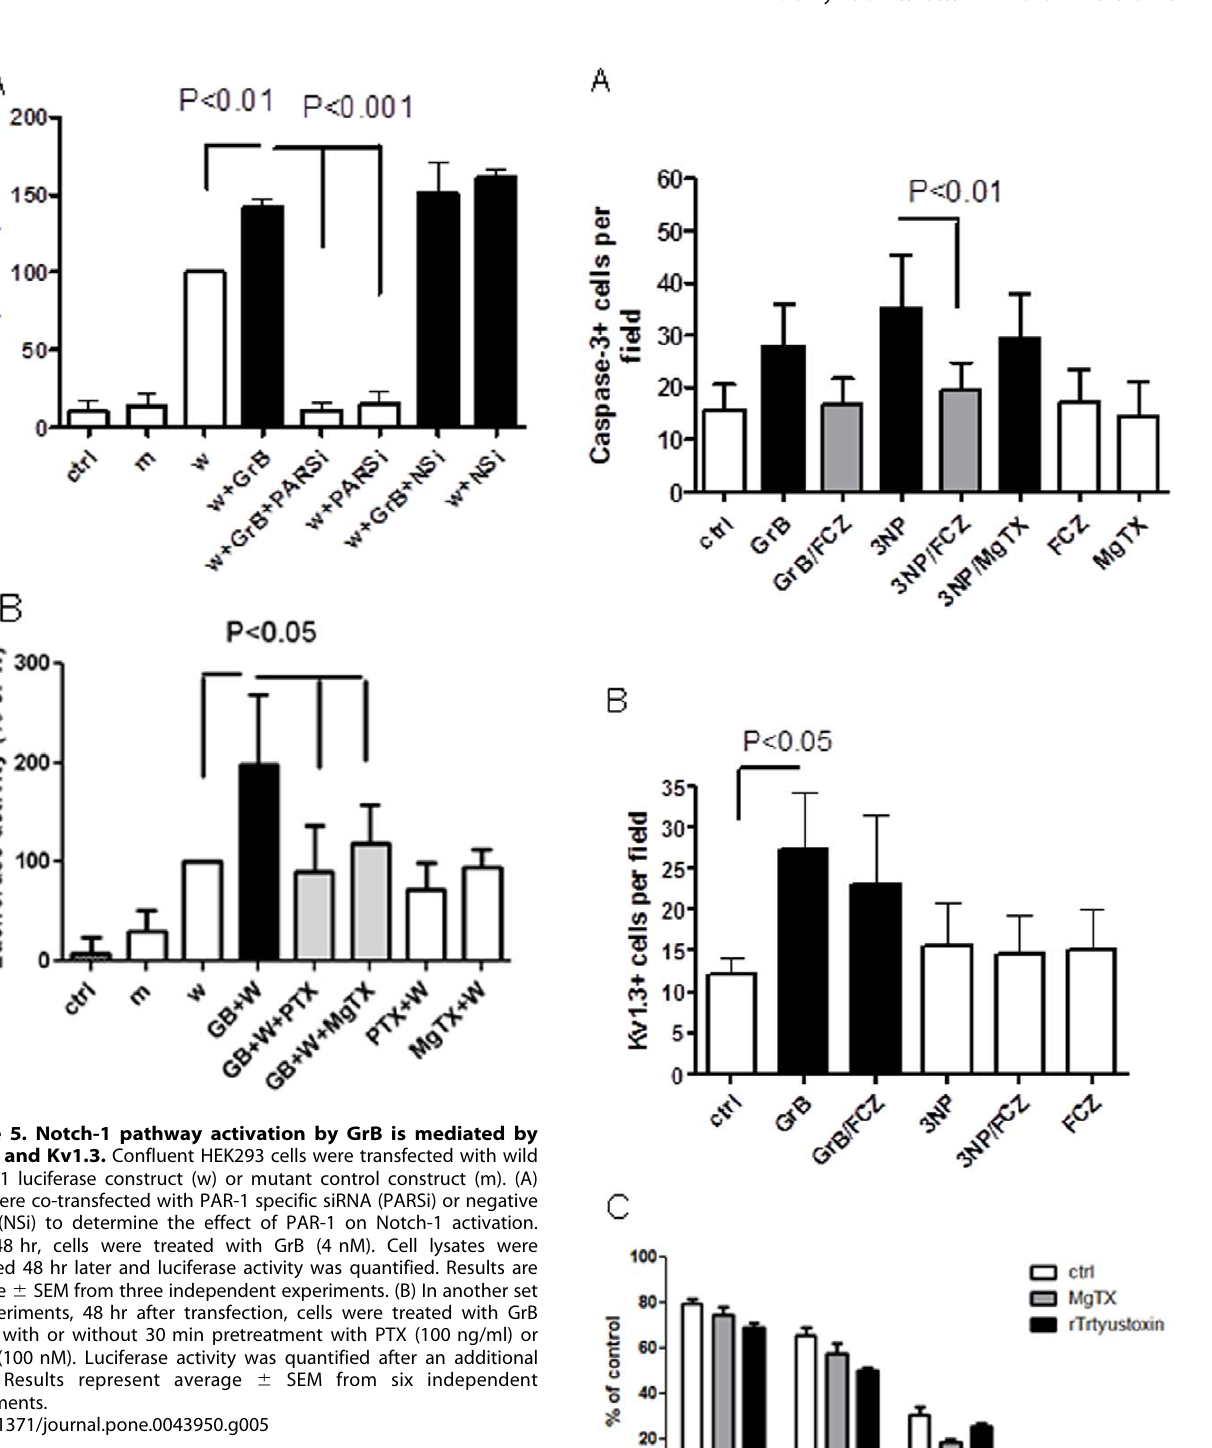
primary cultures of human neuronal cells to investigate the mechanisms of GrB-induced neurotoxicity. We observed that GrB binds to the cell membrane receptor PAR-1 and activates the receptor by cleavage, resulting in decreased intracellular cAMP level and activation of Kv1.3 channel. This was followed by activation of the Notch-1 pathway, leading to damaged neurons (Figure 9).